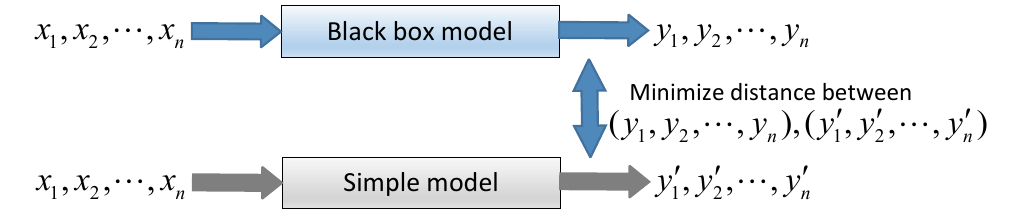
Figure 6. The general principle of the global mimic